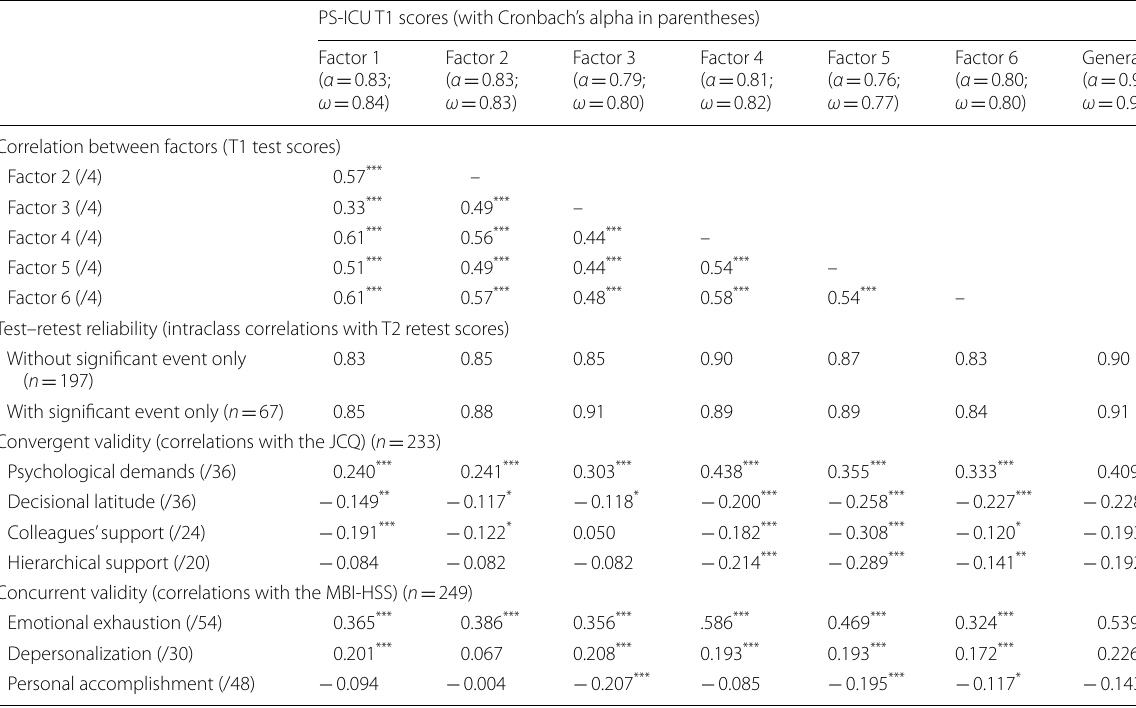
Table 5 Results of test–retest reliability and validity of the PS‑ICU scale